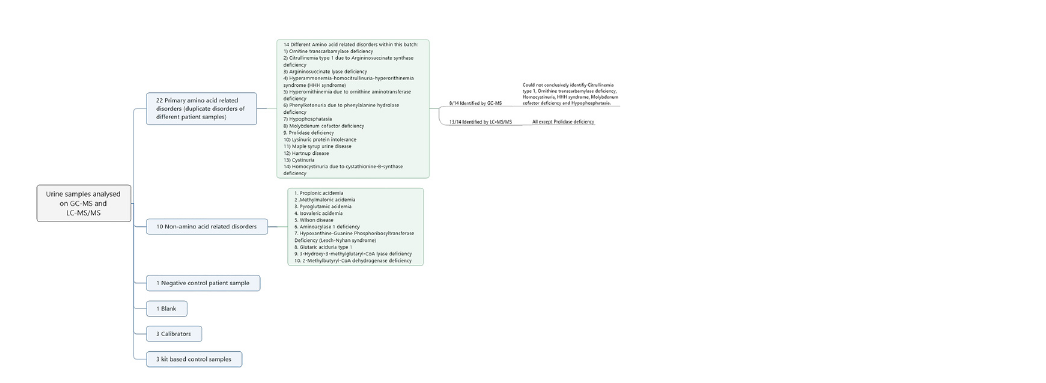
Figure 1: Dual experimental design of amino acid analysis on GC-MS and LC-MS/MS of anonymised